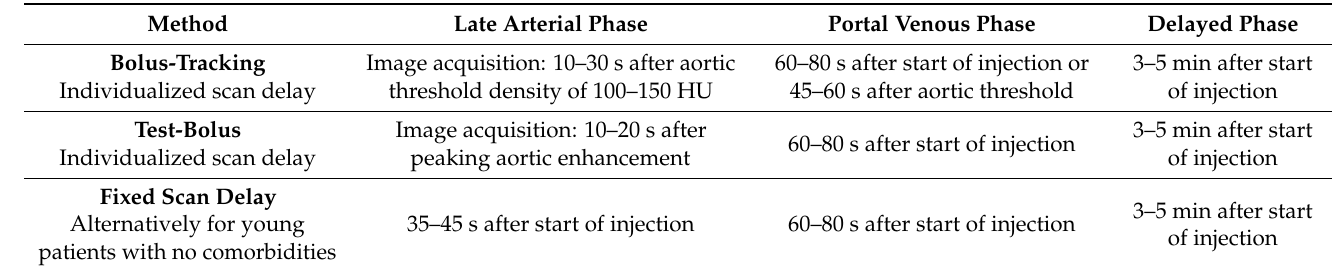
Table 4. Multiphase Liver CT Imaging and Scan Delay Parameters